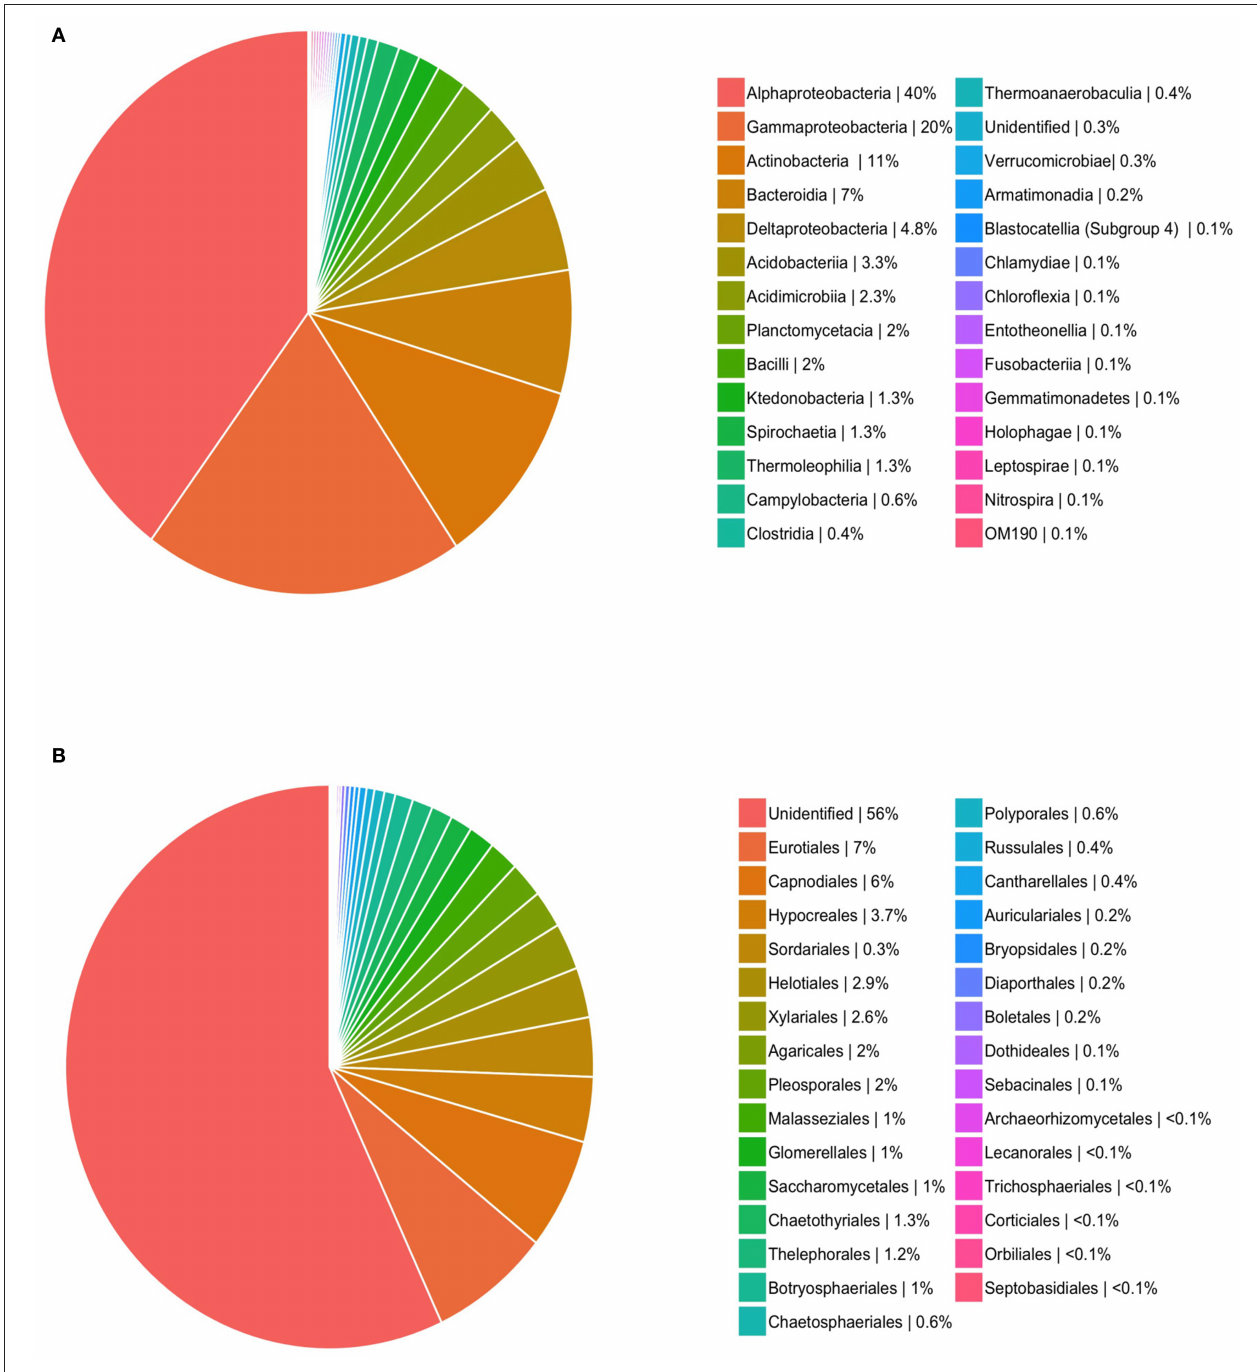
FIGURE 2 | Relative occurrence (i.e., number of times each order occurs in sampled leaves out of total pool of occurrences) for OTU orders for (A) bacteria and (B) fungi.